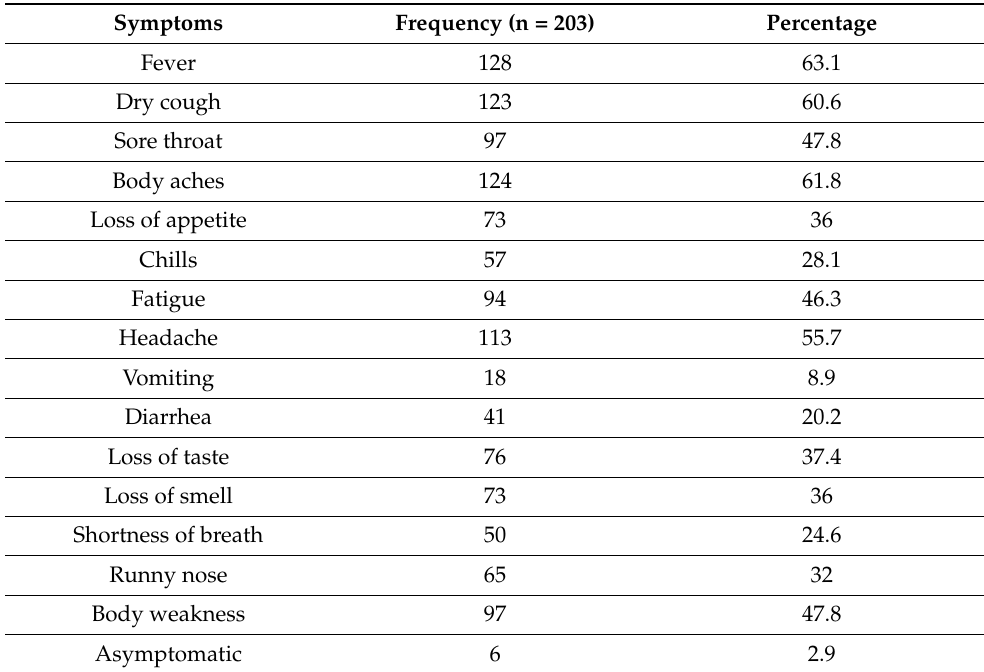
Figure 2. Number of COVID-19 cases among healthcare workers by job category. Table 3. COVID-19 symptoms among all healthcare